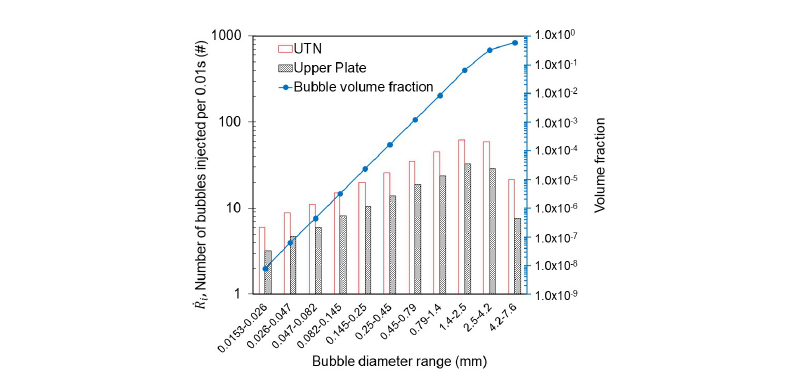
Figure 2. Injection rate and volume fraction of the bubbles.